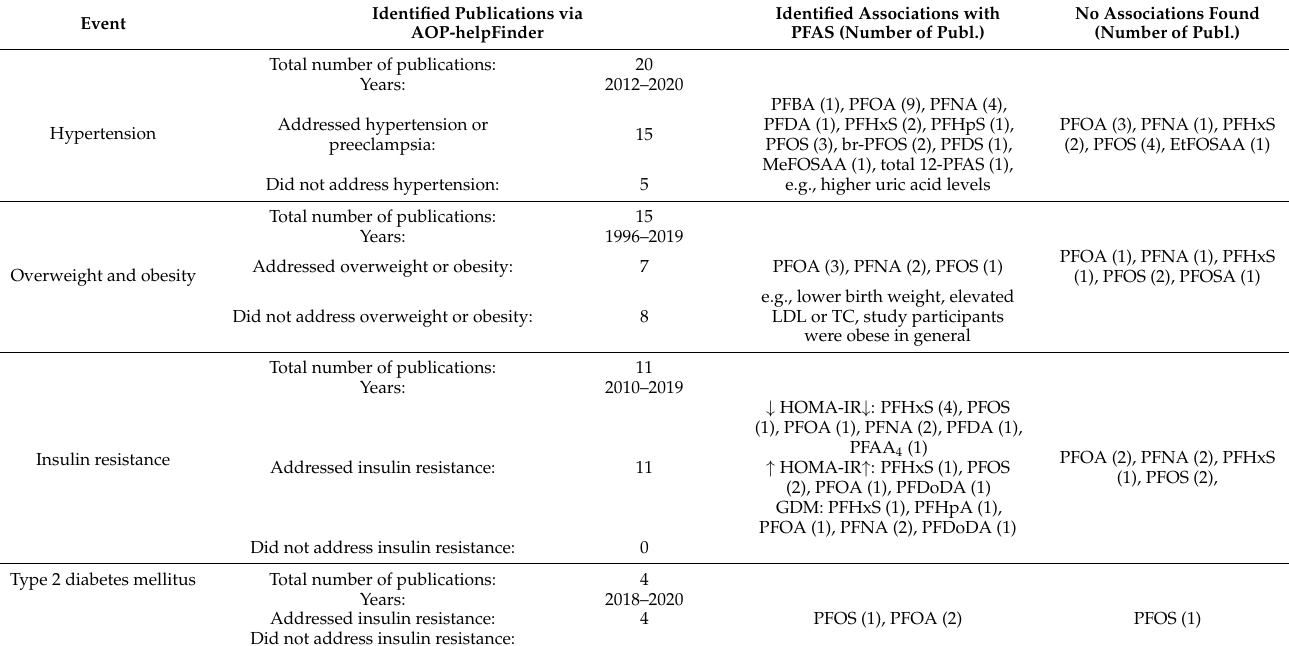
Table 3. Epidemiological study outcomes related to metabolic